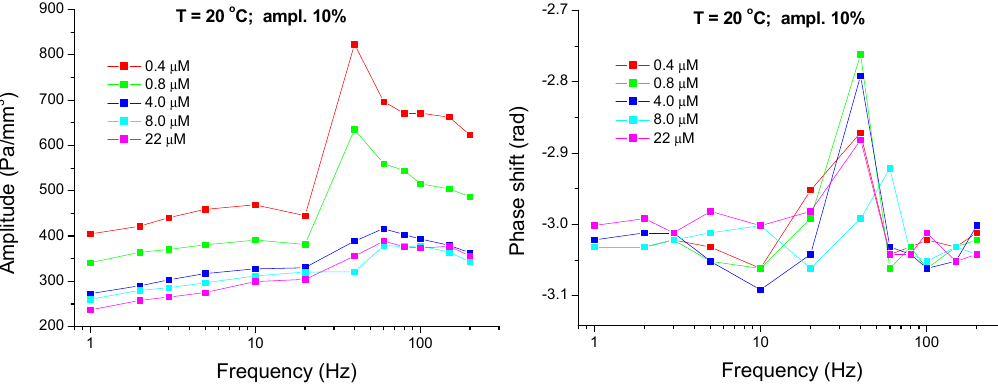
Figure 8. Amplitude- and phase-shift-frequency characteristics for the pressure in chamber A (aqueous matrix-cell) measured for mixed solutions of C 13 DMPO with concentrations of 4.0 × 10 − 7 , 8.0 × 10 − 7 , 4.0 × 10 − 6 , 8.0 × 10 − 6 and 2.2 × 10 − 5 mol/dm 3 (injections 2-1 to 6-1) and TTAB with a fixed concentration of 4.5 × 10 − 5 mol/dm 3 (T = 20 ◦ C; ampl. 10%); the lines are guides for the eye.